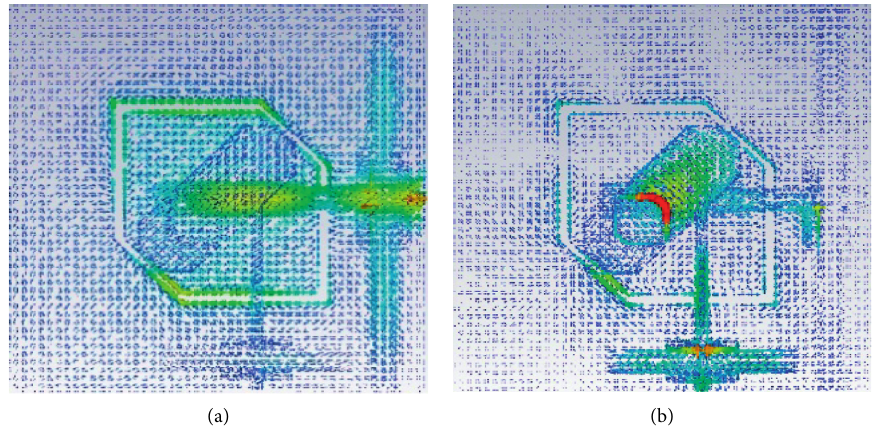
Figure 2: Surface current in (a) 2.45 GHz and (b) 5.8 GHz operating mode.